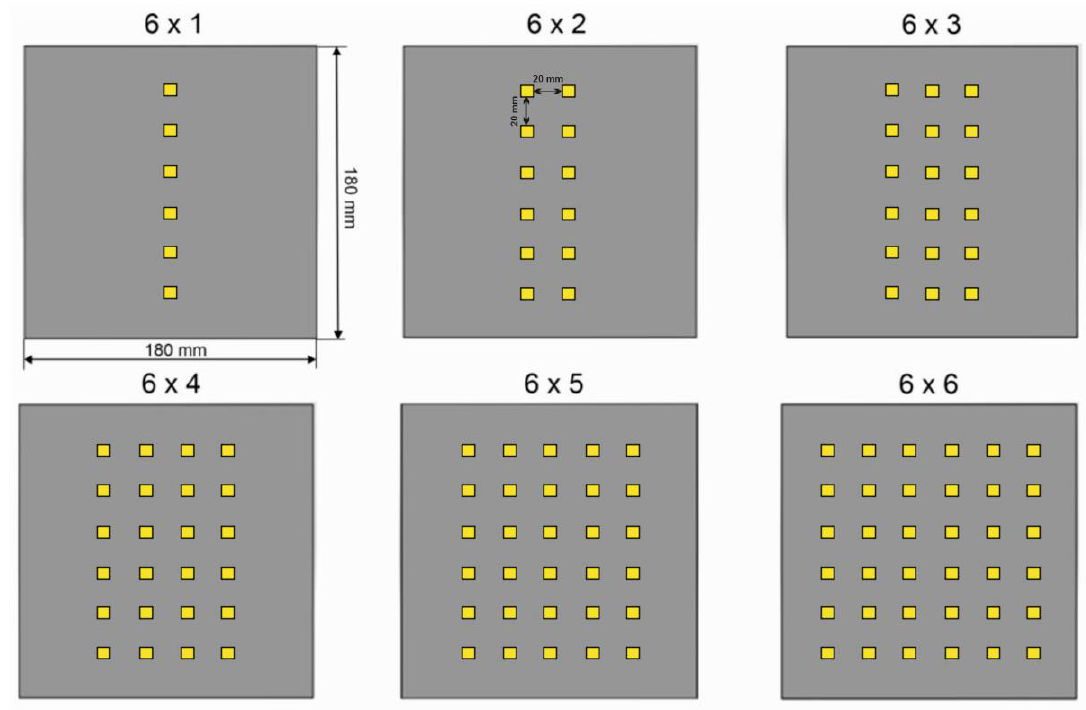
Figure 7. Tested LED panel variants associated with variable number of installed LEDs.